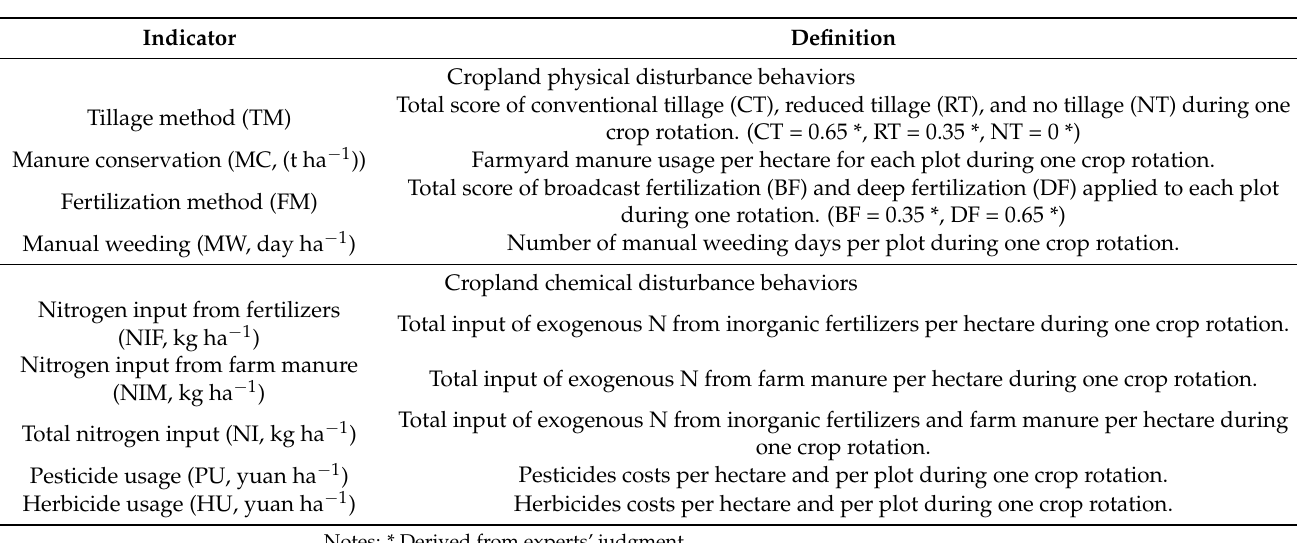
Table 2. Indicators of cropland management behaviors used for exploring differences within the identified household groups.